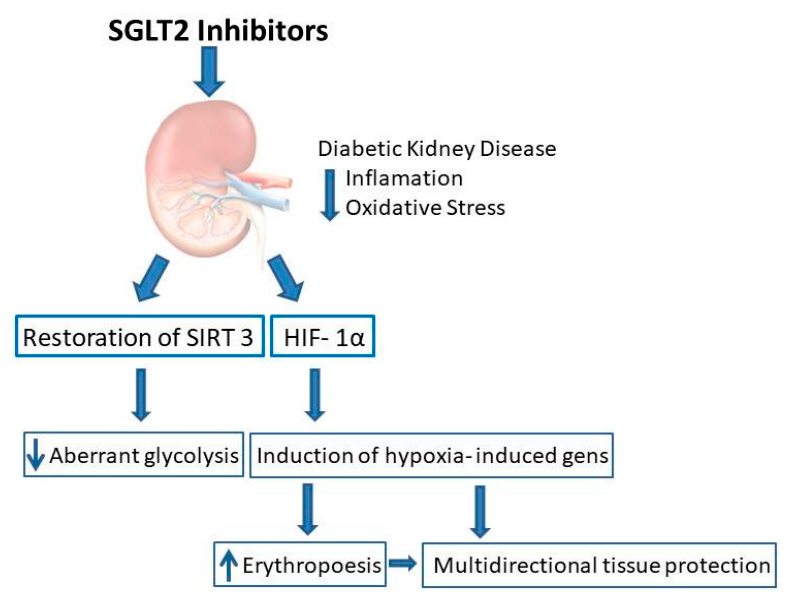
Figure 1. Interaction between SGLT2 inhibition, HIF1 α and tissue protection in diabetic kidney disease. Endothelial cells may also acquire a mesenchymal and then fibroblastic phenotype (EndMT) and thus contribute to scarring and fibrosis of the involved organs. Such a mechanism is operational in the chronic myocardial injury in diabetes. Tian et al. induced diabetes in Sprague − Dawley rats using STZ injection and found that diabetic animals develop systolic and diastolic dysfunction of the heart as well as hypertrophy of heart structures. Animals treated with dapagliflozin or metformin were characterized by significantly improved cardiac function and were protected from cardiac remodeling.